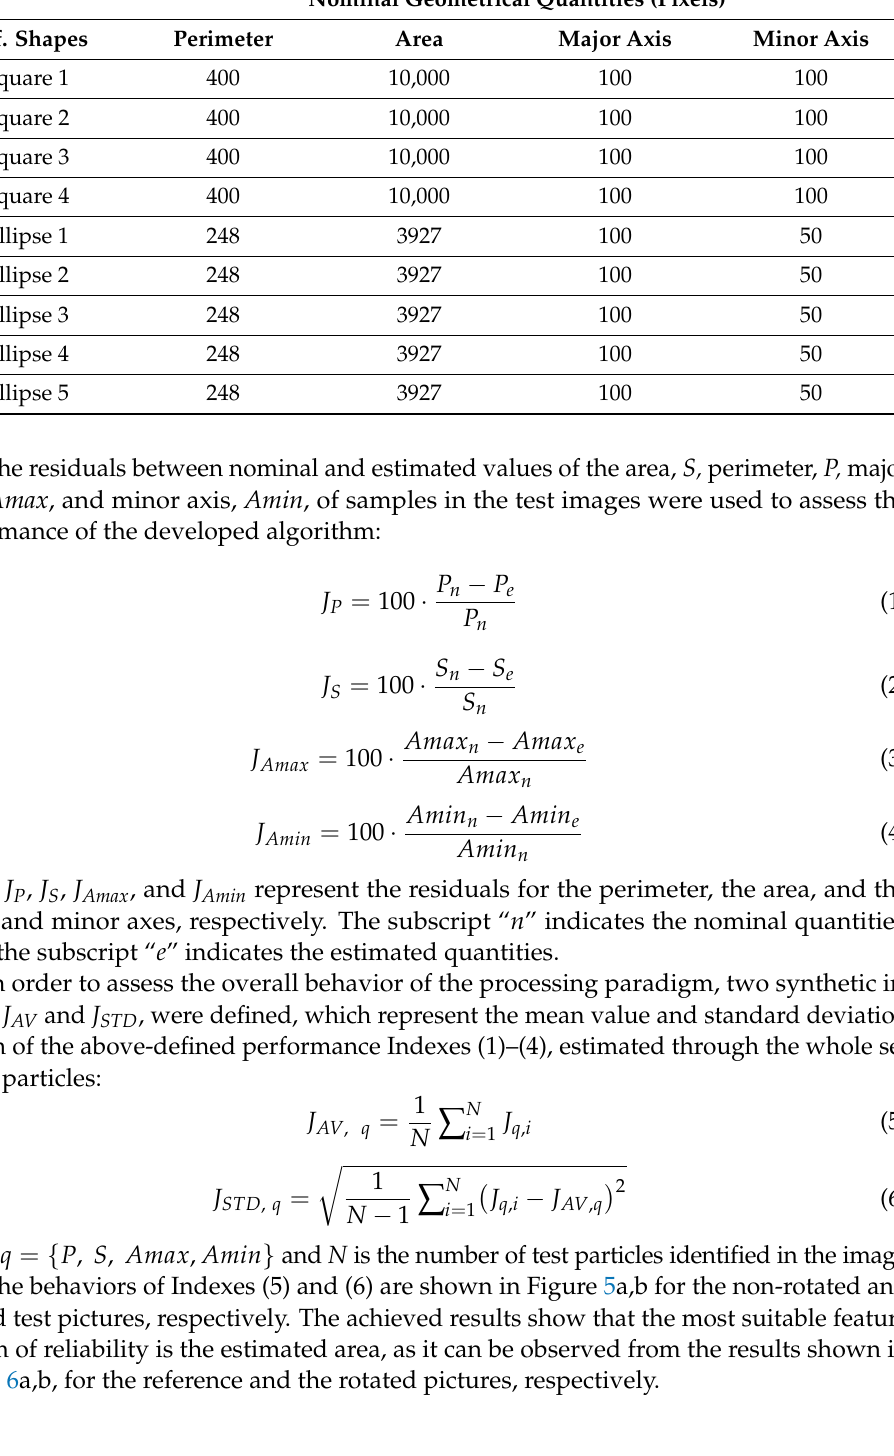
Table 2. Nominal characteristics, in pixels, of the test figures reported on the rotated picture (from top-left to bottom-right). Nominal Geometrical Quantities (Pixels) Ref. Shapes Perimeter Area Major Axis Minor Axis Square 1 400 10,000 Square